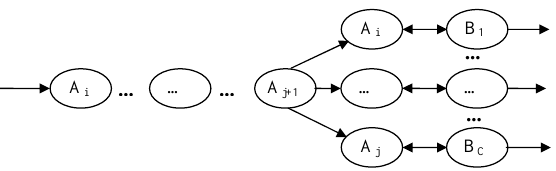
Fig. 6. Interaction behaviors process.